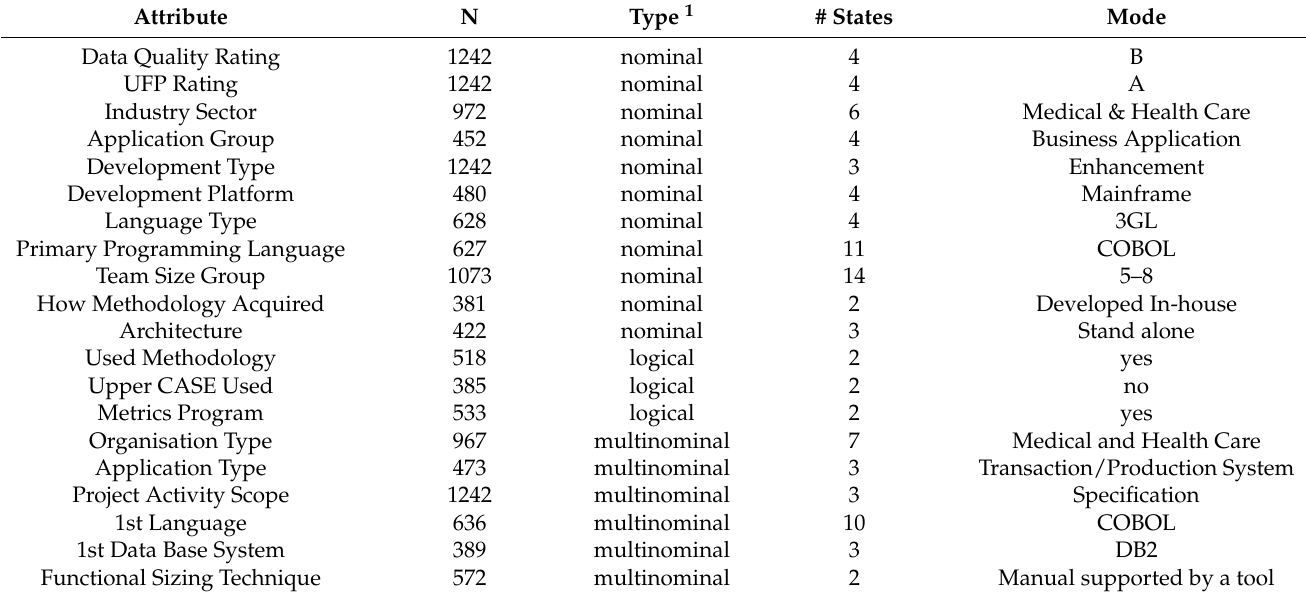
Table 2. Summary statistics for nominal attributes.